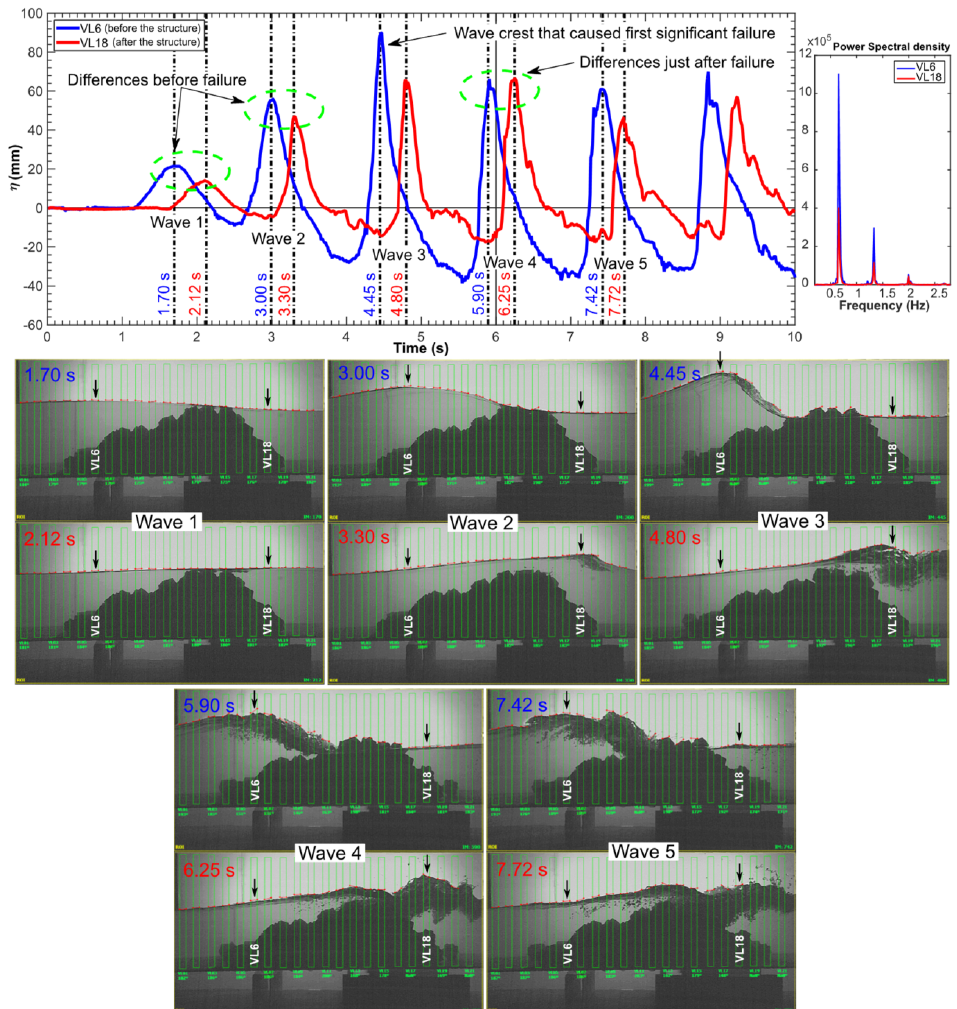
Figure 12. Above: comparison of water elevations measured by the virtual level (VL) sensors VL6 and VL18, located just before and after the structure, respectively, during the first interactions of waves with the structure. The power spectral density of the signals is included. Below: snapshots representative of the maximum elevations measured by these